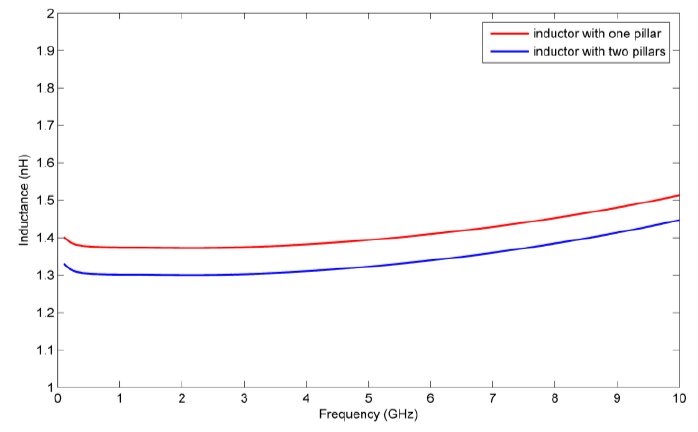
Figure 18. Inductances of the inductors with single and double auxiliary pillar(s).